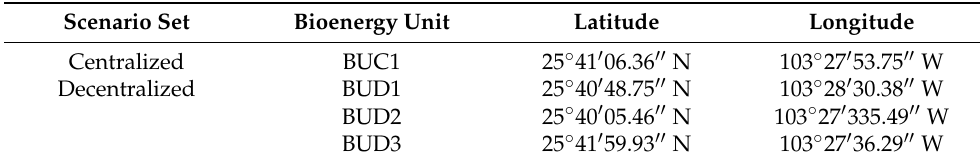
Table 4. Optimal geographical locations for centralized and decentralized biodigesters units and livestock producers.